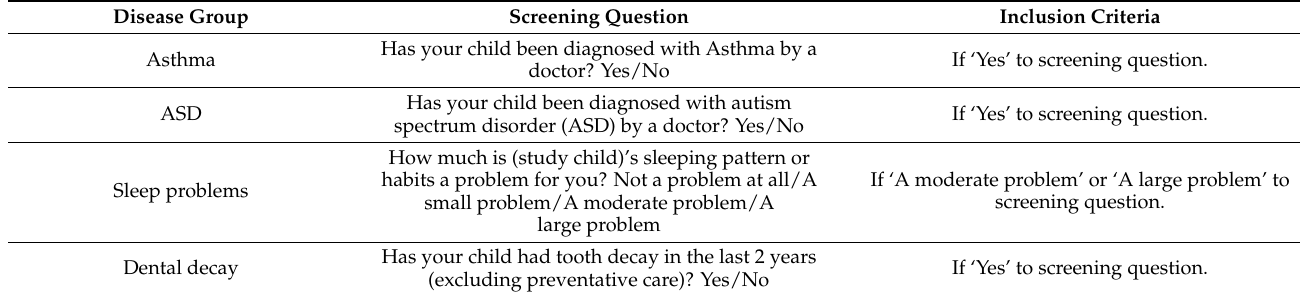
Table A2. Disease group screening questions for sample